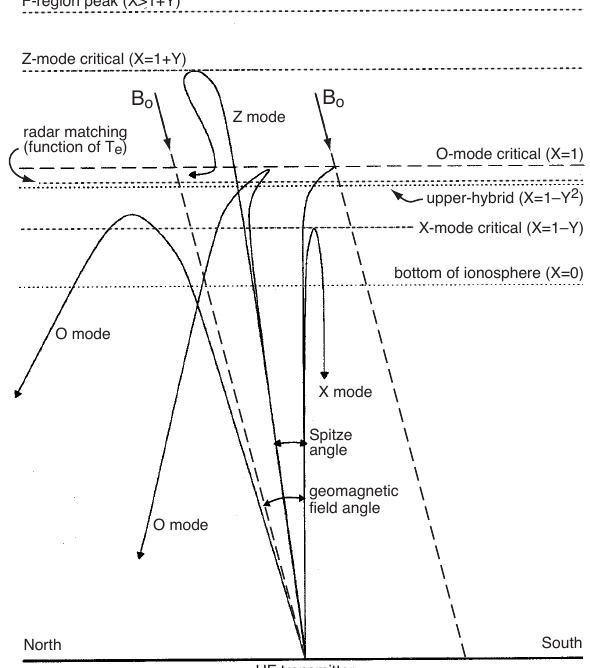
Isham et al. Figure 2 Fig. 2. Bottom- and topside ion and plasma line enhancements ob- served at EISCAT. Adapted from Isham et al. (1999c), Figs. 1 and